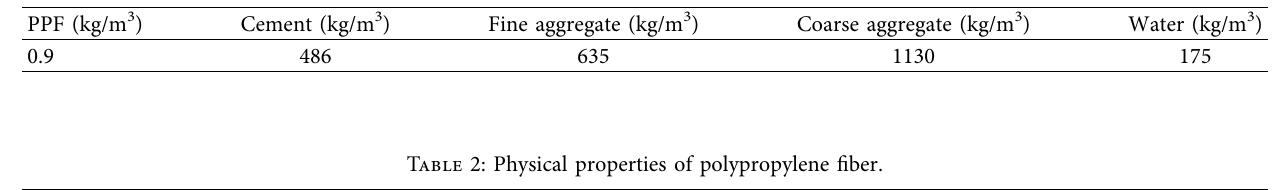
Table 1: Mix ratio of concrete.